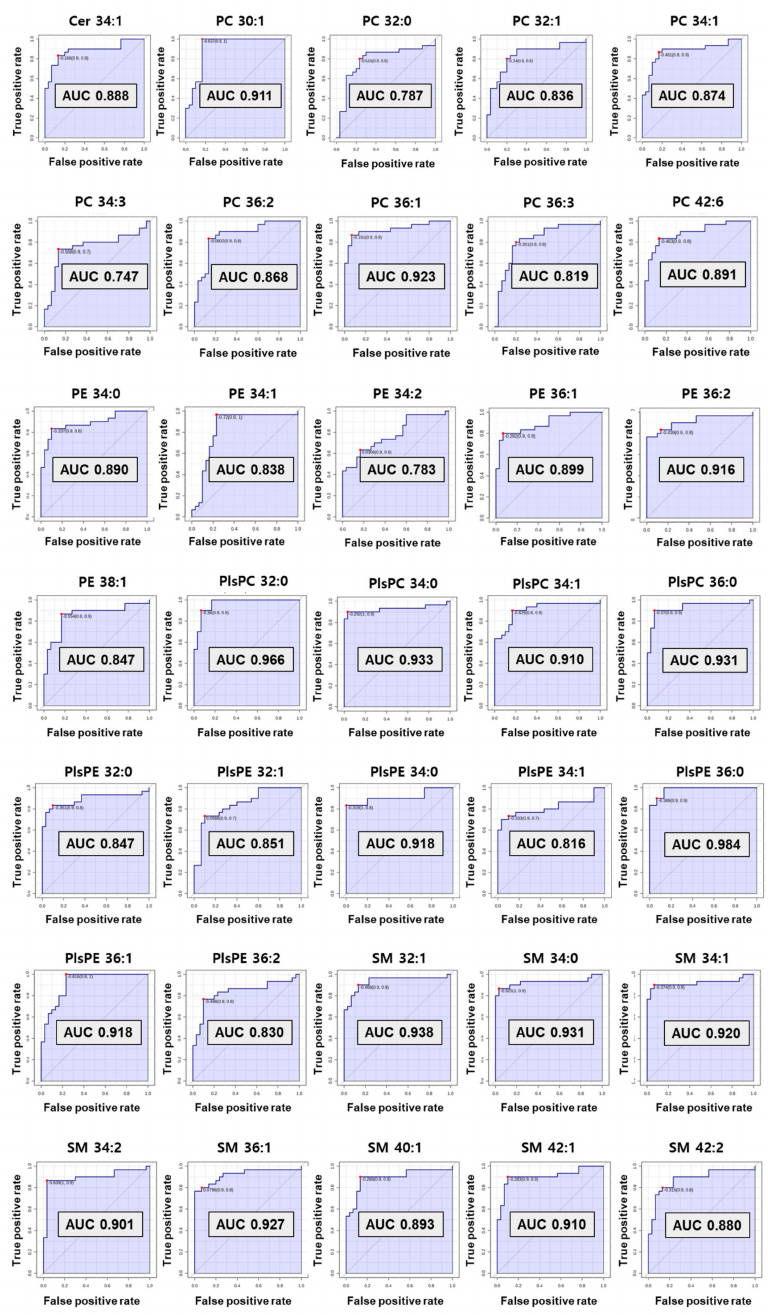
Figure 5. The receiver operating characteristic (ROC) curve of selected biomarkers. AUC values more than 0.7 have potential as